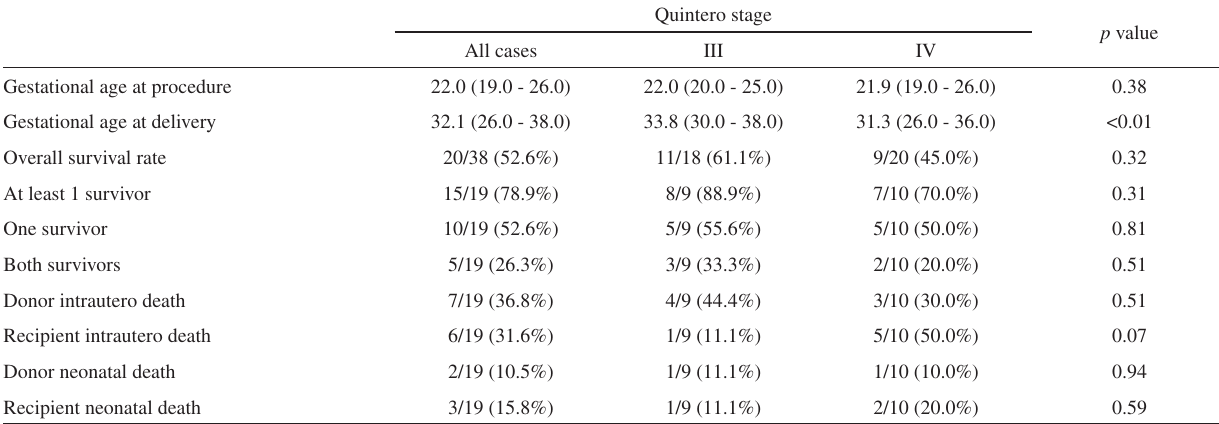
Table 1 - Perinatal results of 19 pregnancies with TTTS stages III and IV treated with fetoscopic laser photocoagulation